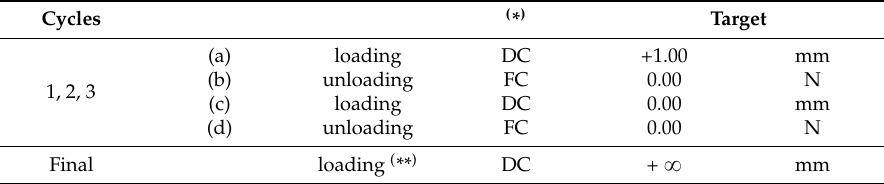
Table 4. Multi-step testing procedure (main experiments).